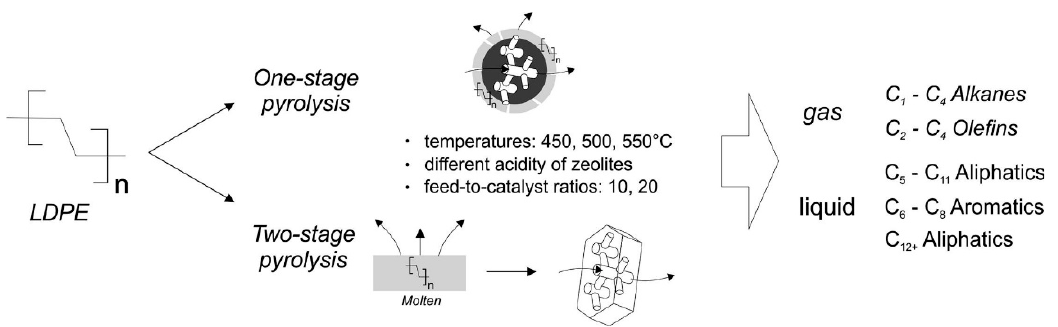
Figure 2. Scheme showing low-density polyethylene (LDPE) pyrolysis–catalysis conversion of zeolite catalysts in one- and two-stage manners [86].